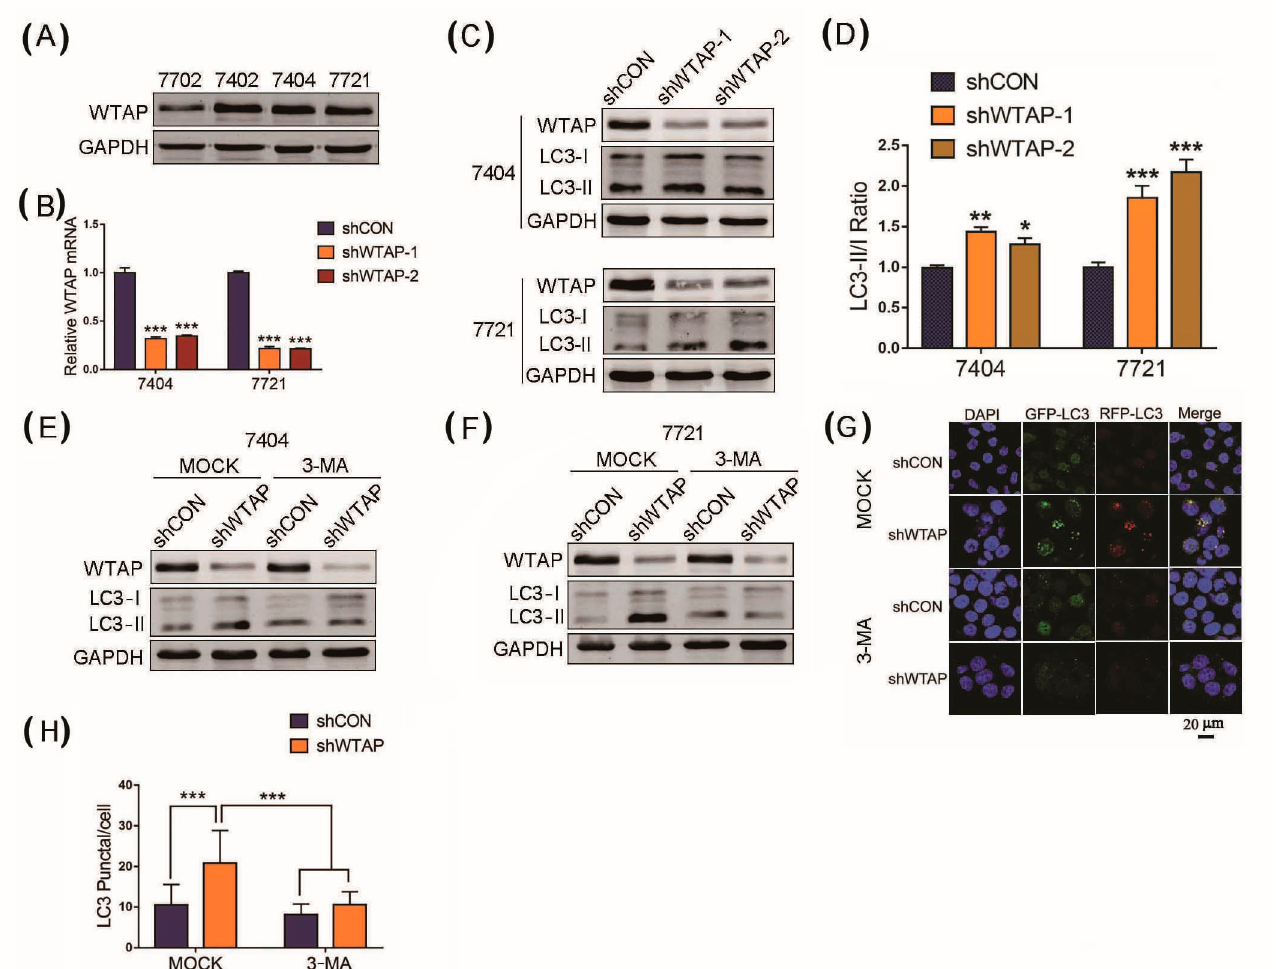
Figure 1. Knockdown of WTAP facilitating autophagy of HCC. ( A ) Western blot analysis of basal expression of WTAP in different HCC cell lines. ( B ) RT-qPCR analysis of WTAP transcripts from shWTAP cells and shCON cells. ( C ) Western blot analysis of LC3-I and LC3-II in shWTAP SMMC-7721 cells and shWTAP BEL-7404 cells. ( D ) Statistical analysis of LC3 II/LC3 I ratio between shCON and shWTAP group. ( E ) Western blot analysis of LC3-I and LC3-II in WTAP-knockdown BEL-7404 cells treated with or without 3-MA. ( F ) Western blot analysis of LC3-I and LC3-II in WTAP-knockdown SMMC- 7721 cells treated with or without 3-MA. ( G ) Cofocal microscopy analysis of LC3 in shWTAP cells treated with or without 3-MA. ( H ) Statistical analysis of LC3 puncta in shWTAP cells and shCON cells, as well as 3-MA-treated cells. Error bars indicate the mean ± SD from three independent experiments ( n = 3). * p < 0.05, ** p < 0.01, *** p <